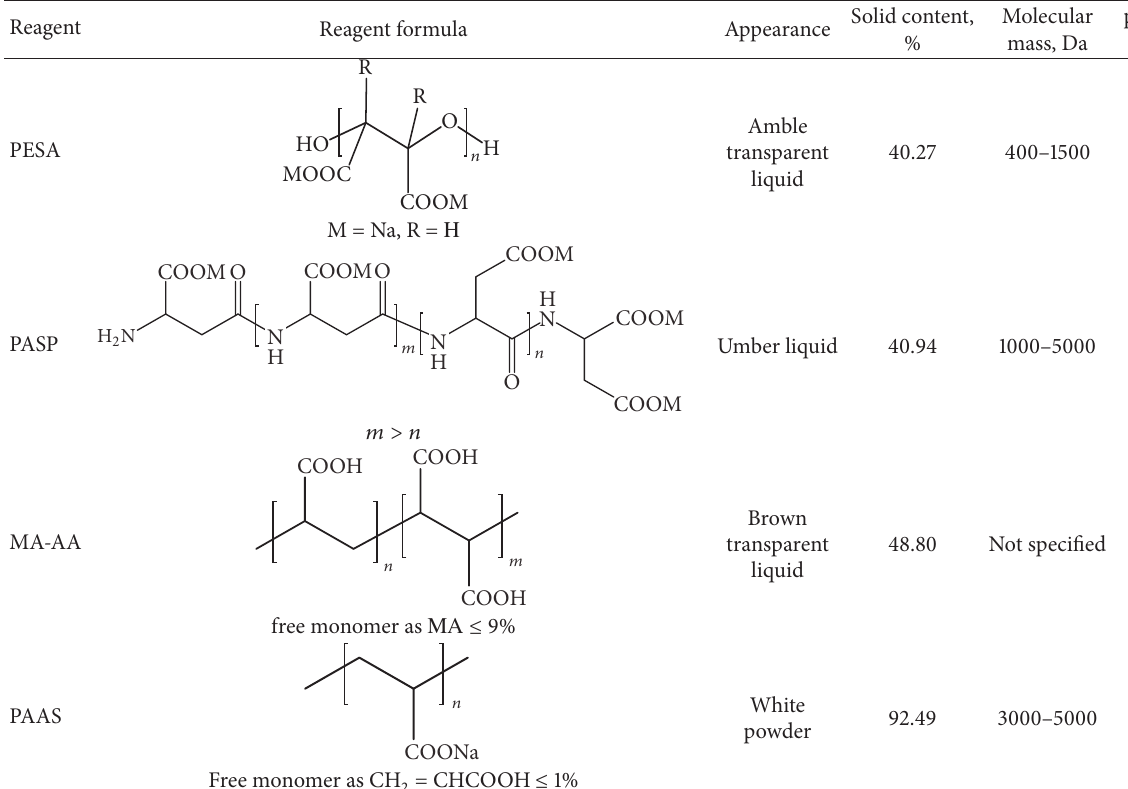
Table 1: Polymers studied as scale inhibitors in calcium carbonate supersaturated